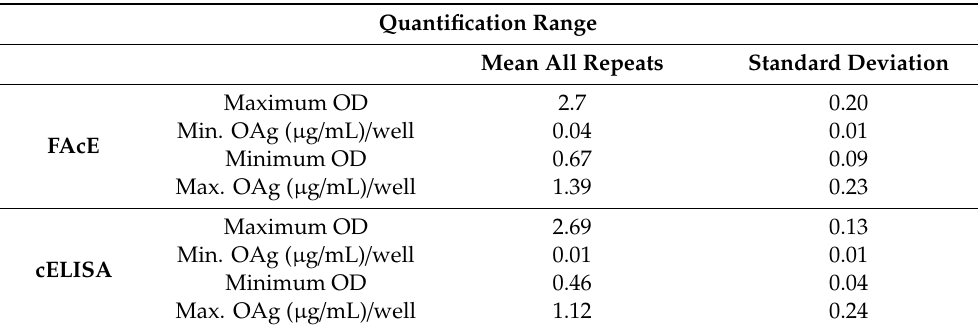
Table 1. Quantification